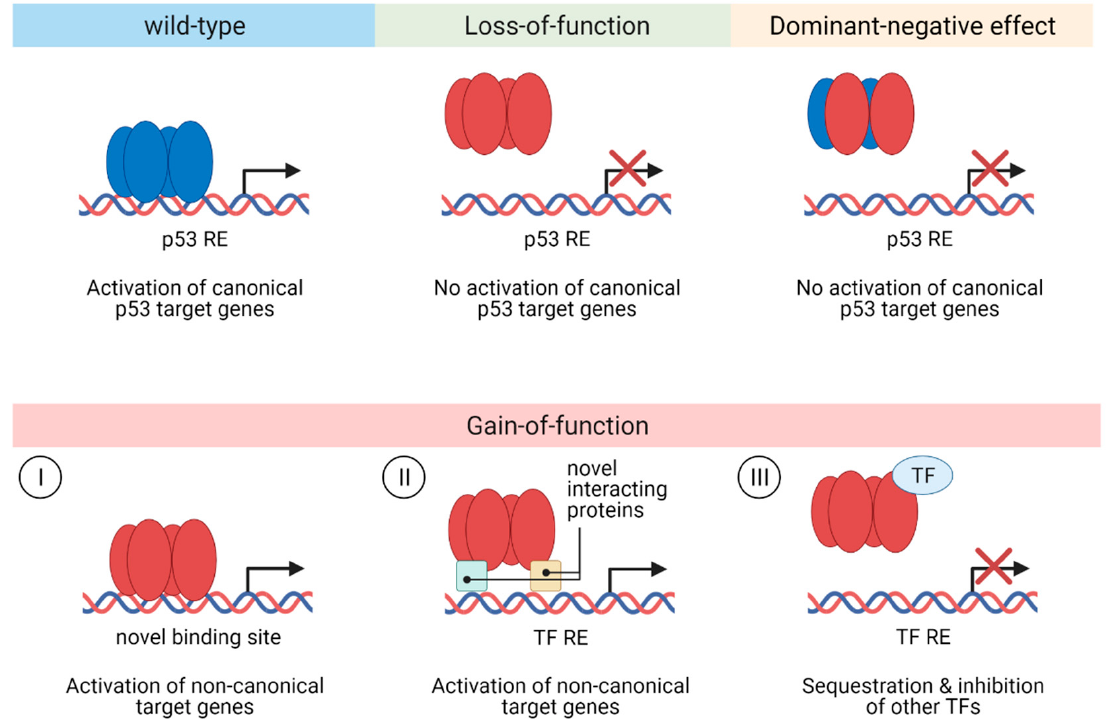
Figure 4. Functional consequences of p53 mutations. p53 mutations can lead to a loss-of-function of wild-type p53 activity abrogating the ability of mutant p53 to transactivate canonical p53 target genes. p53 mutants co-occurring with wild-type p53 can diminish canonical p53 target gene expression via exerting a dominant-negative effect over wild-type p53 by forming hetero-oligomers and preventing binding of wild-type p53 to its response elements. Mutant p53 proteins can also obtain gain-of-function activities by acquiring novel, non-canonical pro-tumorigenic functions through different molecular mechanisms. ( I ) The binding of mutant p53 to novel, non-canonical binding sites leads to the transactivation of non- canonical genes. ( II ) Protein–protein interactions (e.g., with other transcription factors or chromatin remodeling complexes) also induce the expression of non-canonical genes. ( III ) Sequestration of other transcription factors via protein–protein interactions with mutant p53 disrupts target gene expression of those transcription factors. RE, response element; TF, transcription